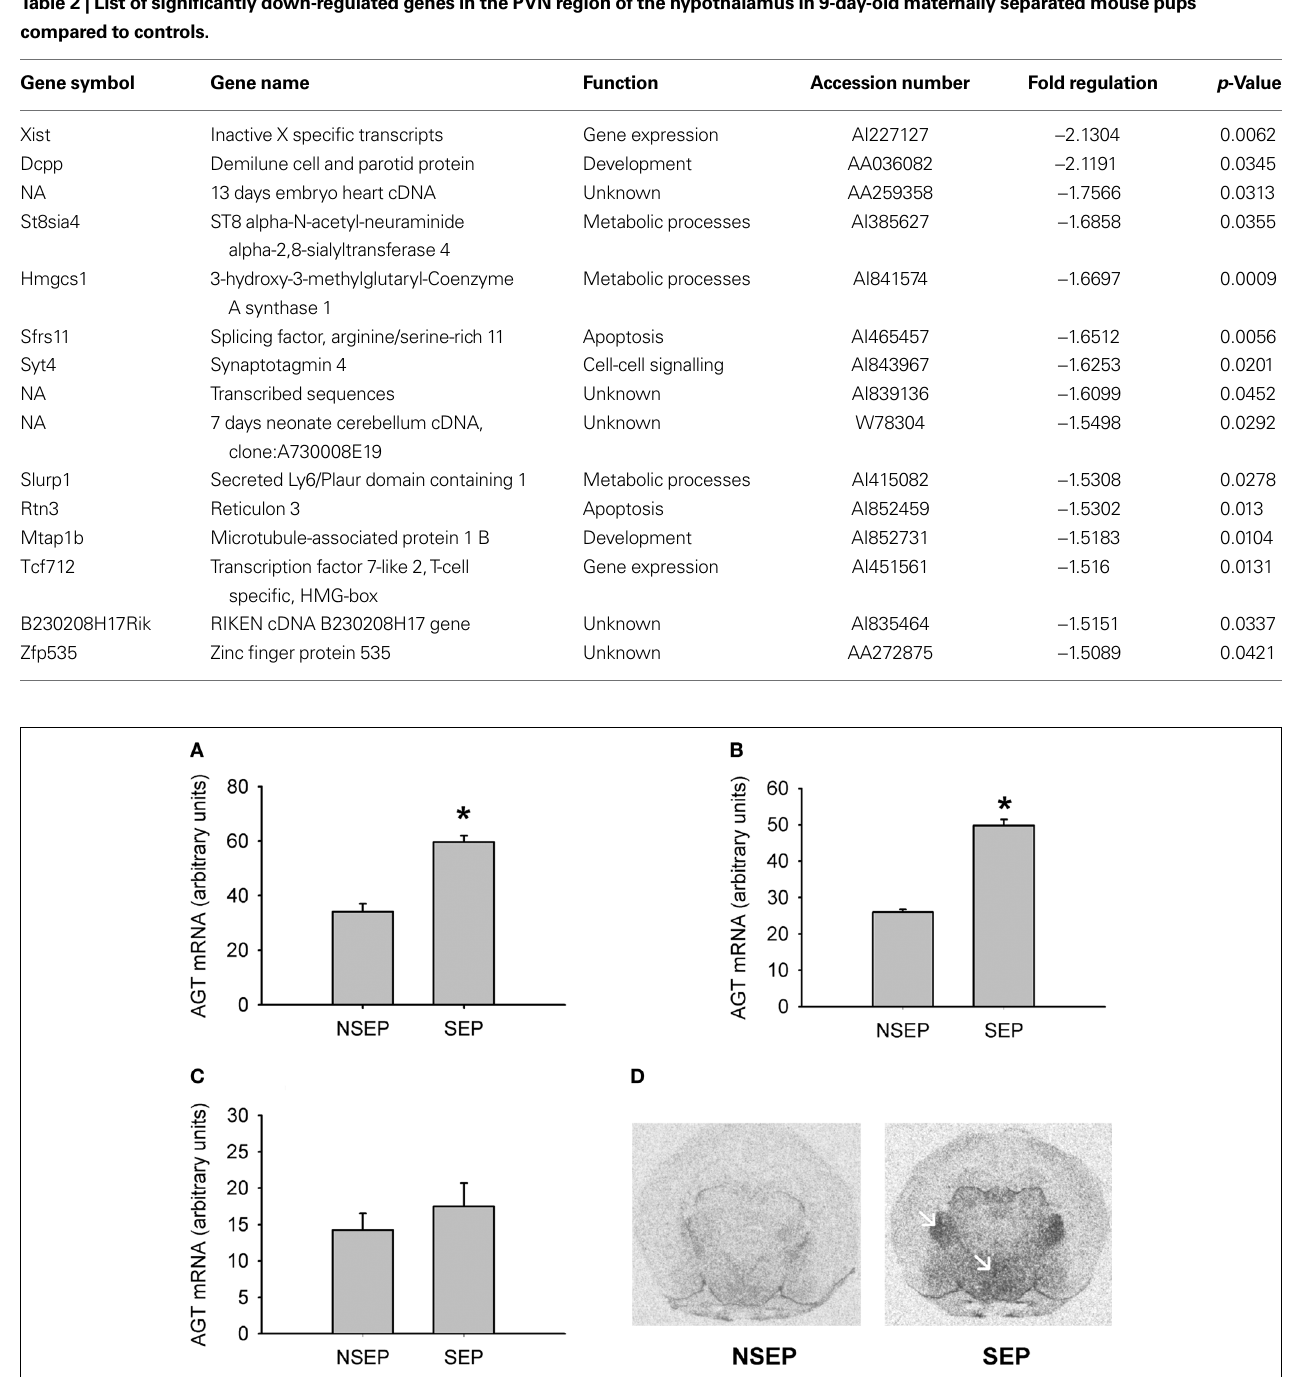
FIGURE 1 | Validation of expression changes of angiotensinogen by in-situ hybridization. A signifi cant up-regulation of angiotensinogen was found in the PVN (A) and the ventral thalamic nucleus (B) . No signifi cant expression differences were observed in the cortex (C) . Figure (D) shows representative autoradiograph pictures of angiotensinogen mRNA expression in maternally non-separated (NSEP) and maternally separated (SEP) animals. Left arrow: ventral thalamic nucleus; right arrow: paraventricular nucleus. *Signifi cant from NSEP, n = 6 per